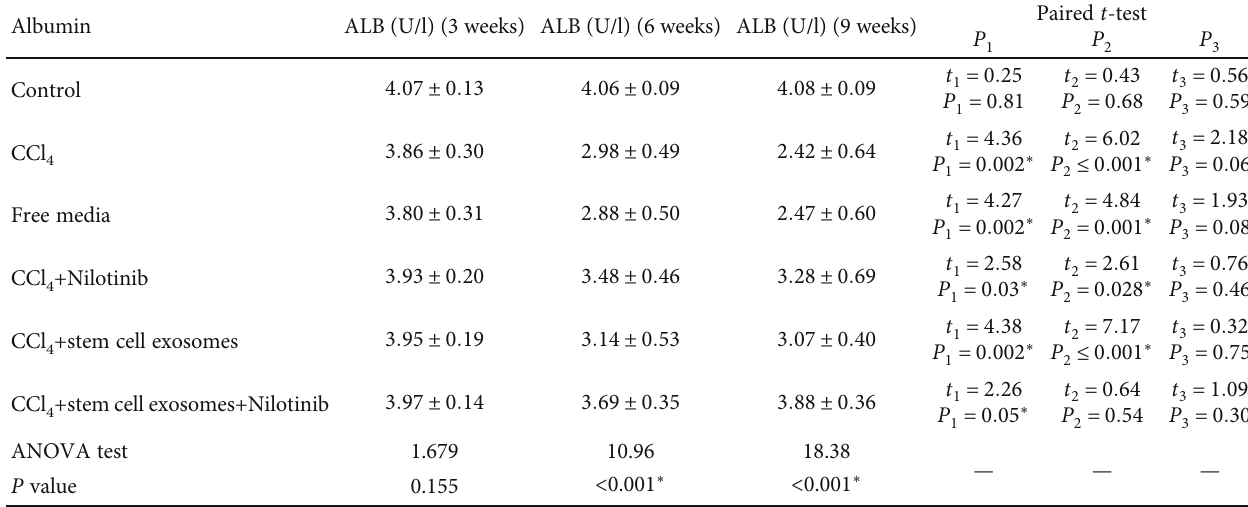
Table 2: ALB ± SD (U/l) among the studied groups after 3 weeks, 6 weeks, and 9 weeks. Albumin